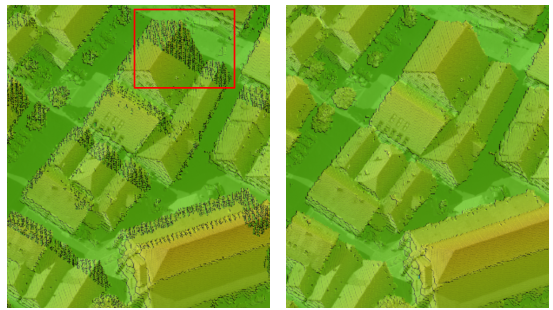
Figure 2. Occlusion